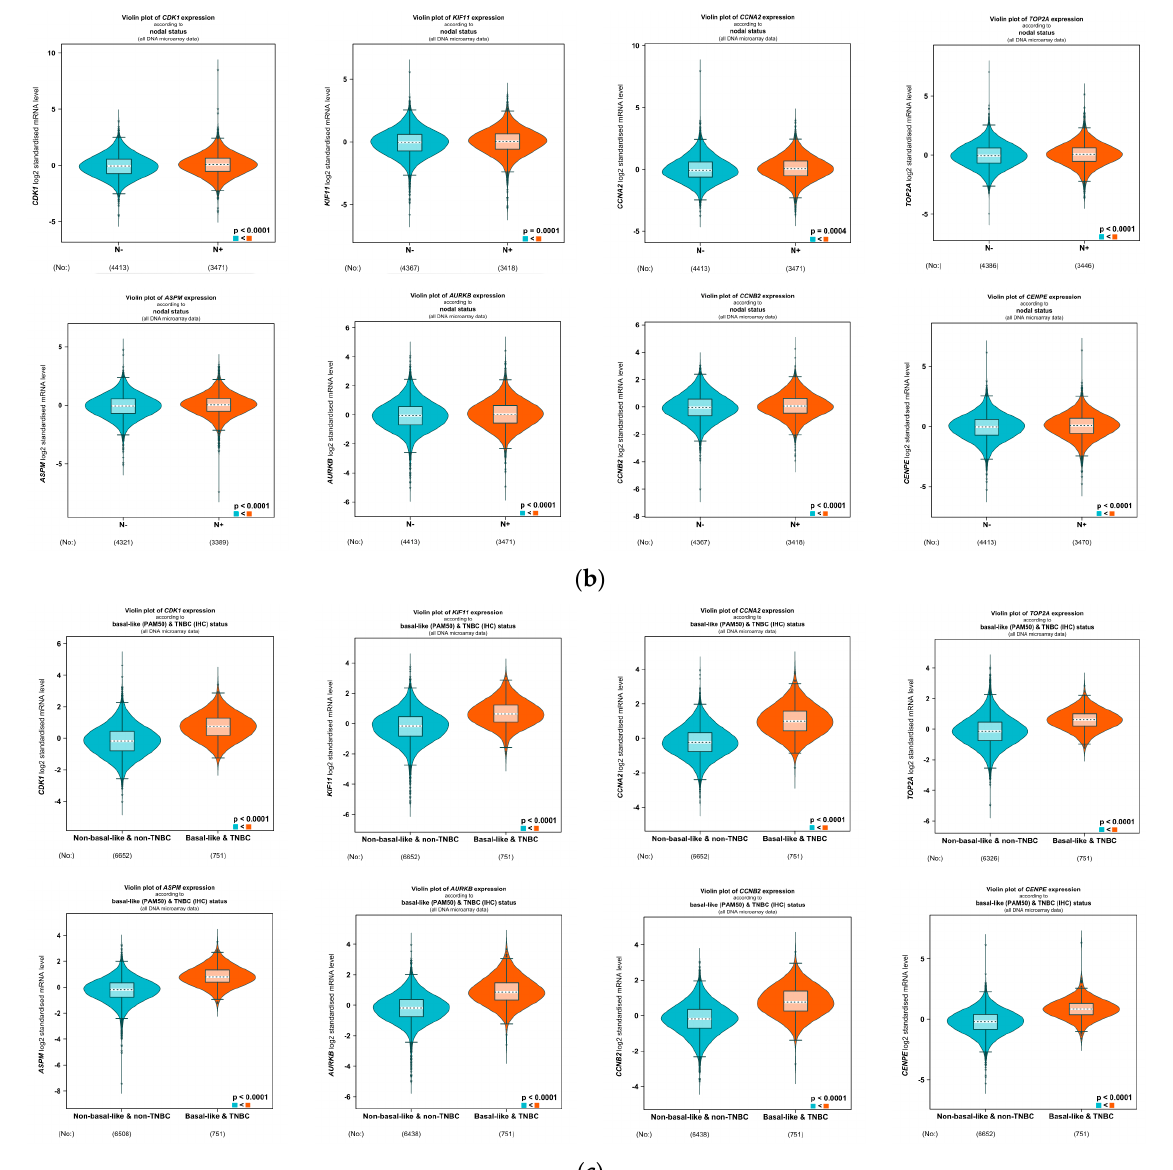
Figure 10. Association between the eight hub genes expression levels and clinicopathological vari- ables ( a ) age, ( b ) nodal status, and ( c ) TNBC & basal-like BC in breast cancer.